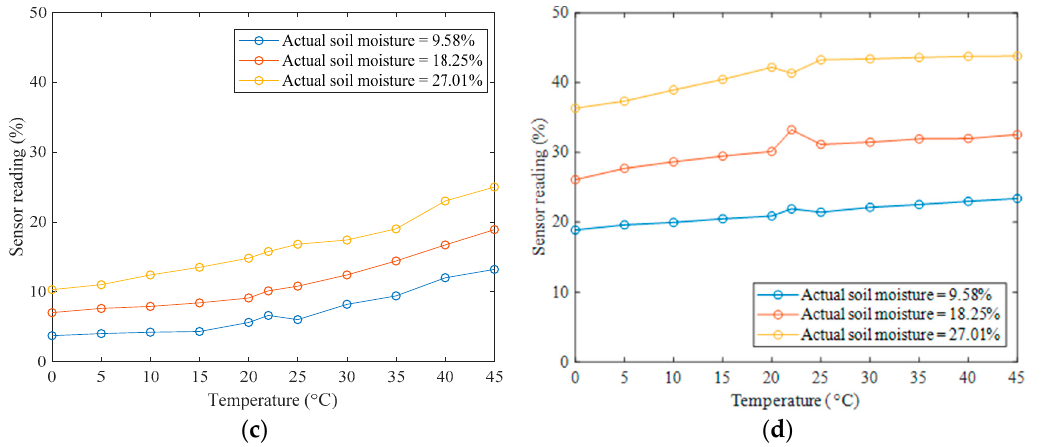
Figure 1. Illustration of sensor readings at various temperatures: ( a ) sensor A; ( b ) sensor B; ( c ) sensor C; and ( d ) sensor D.